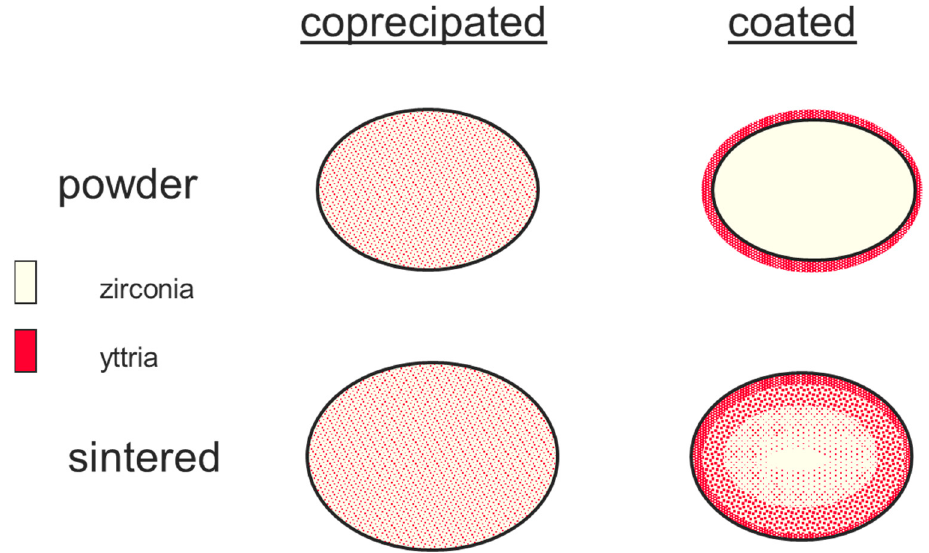
Figure 13. Comparison of “coprecipitation” and “coating” technology (principle!). Figure 13 illustrates the difference between “coprecipiatated” and “coated” powder.